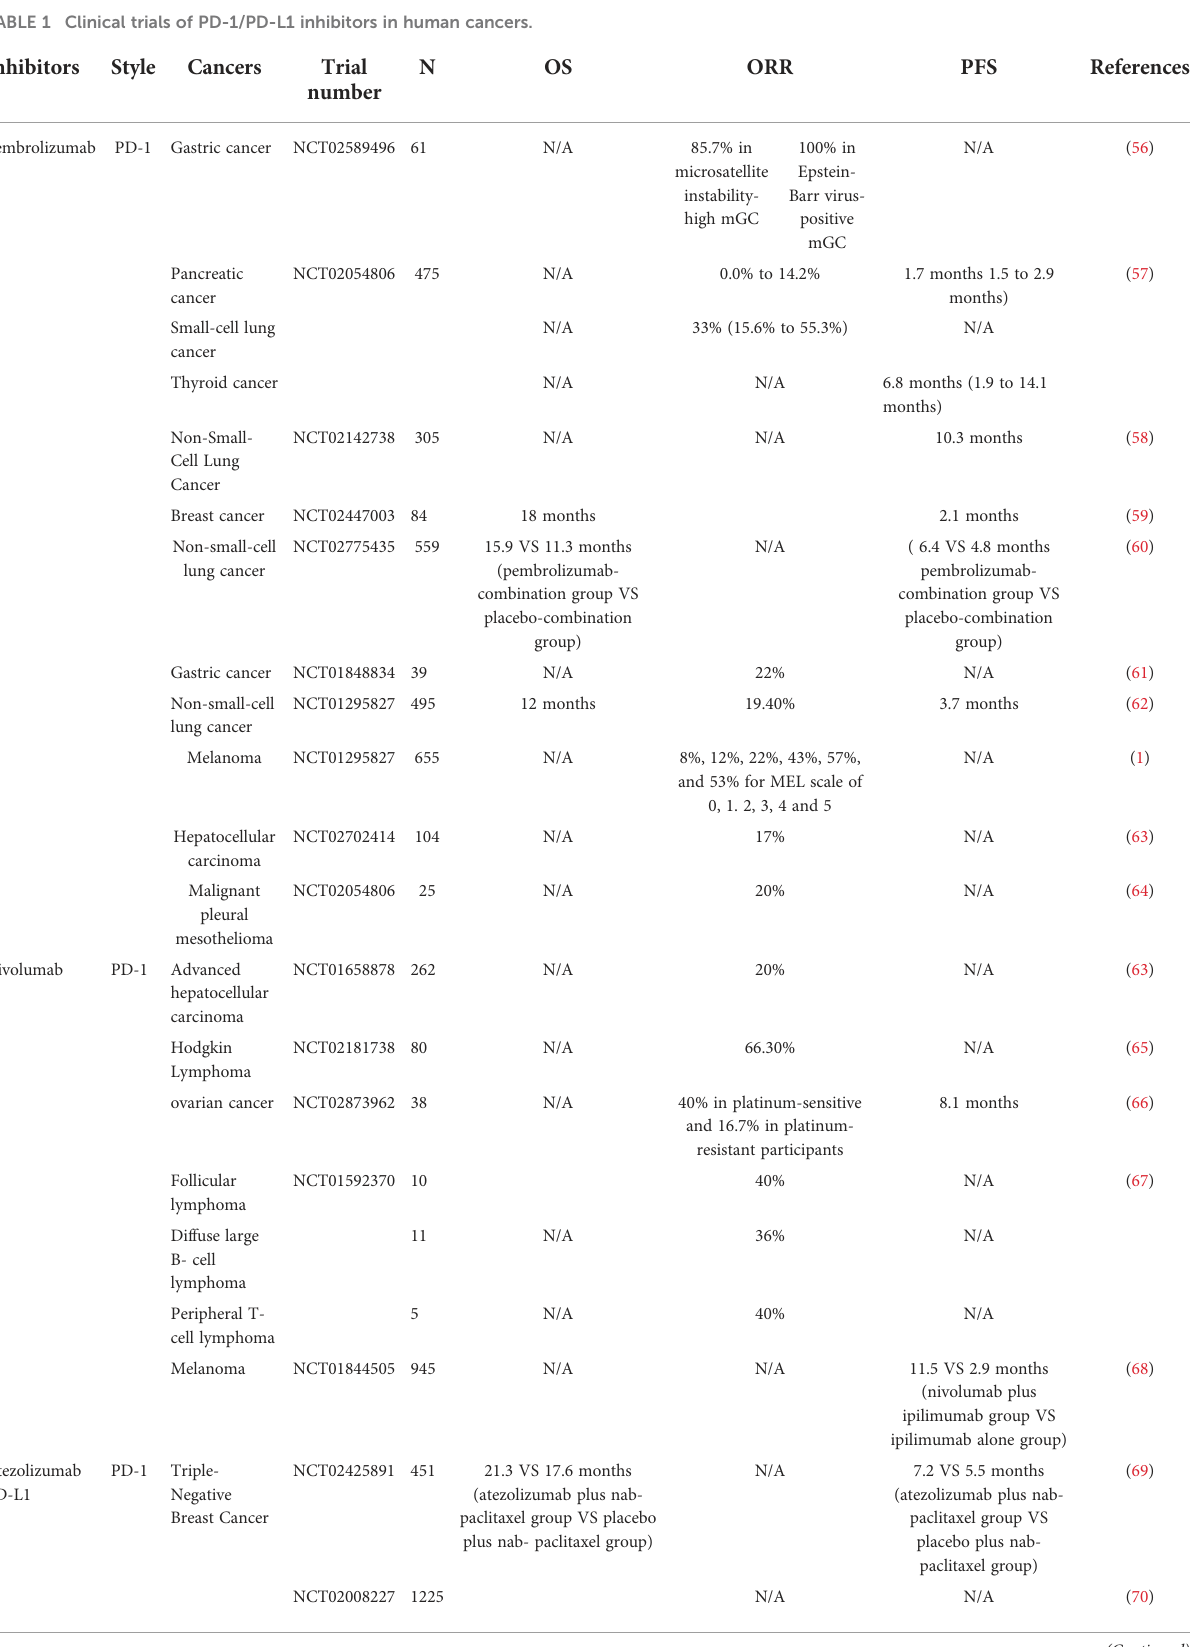
TABLE 1 Clinical trials of PD-1/PD-L1 inhibitors in human